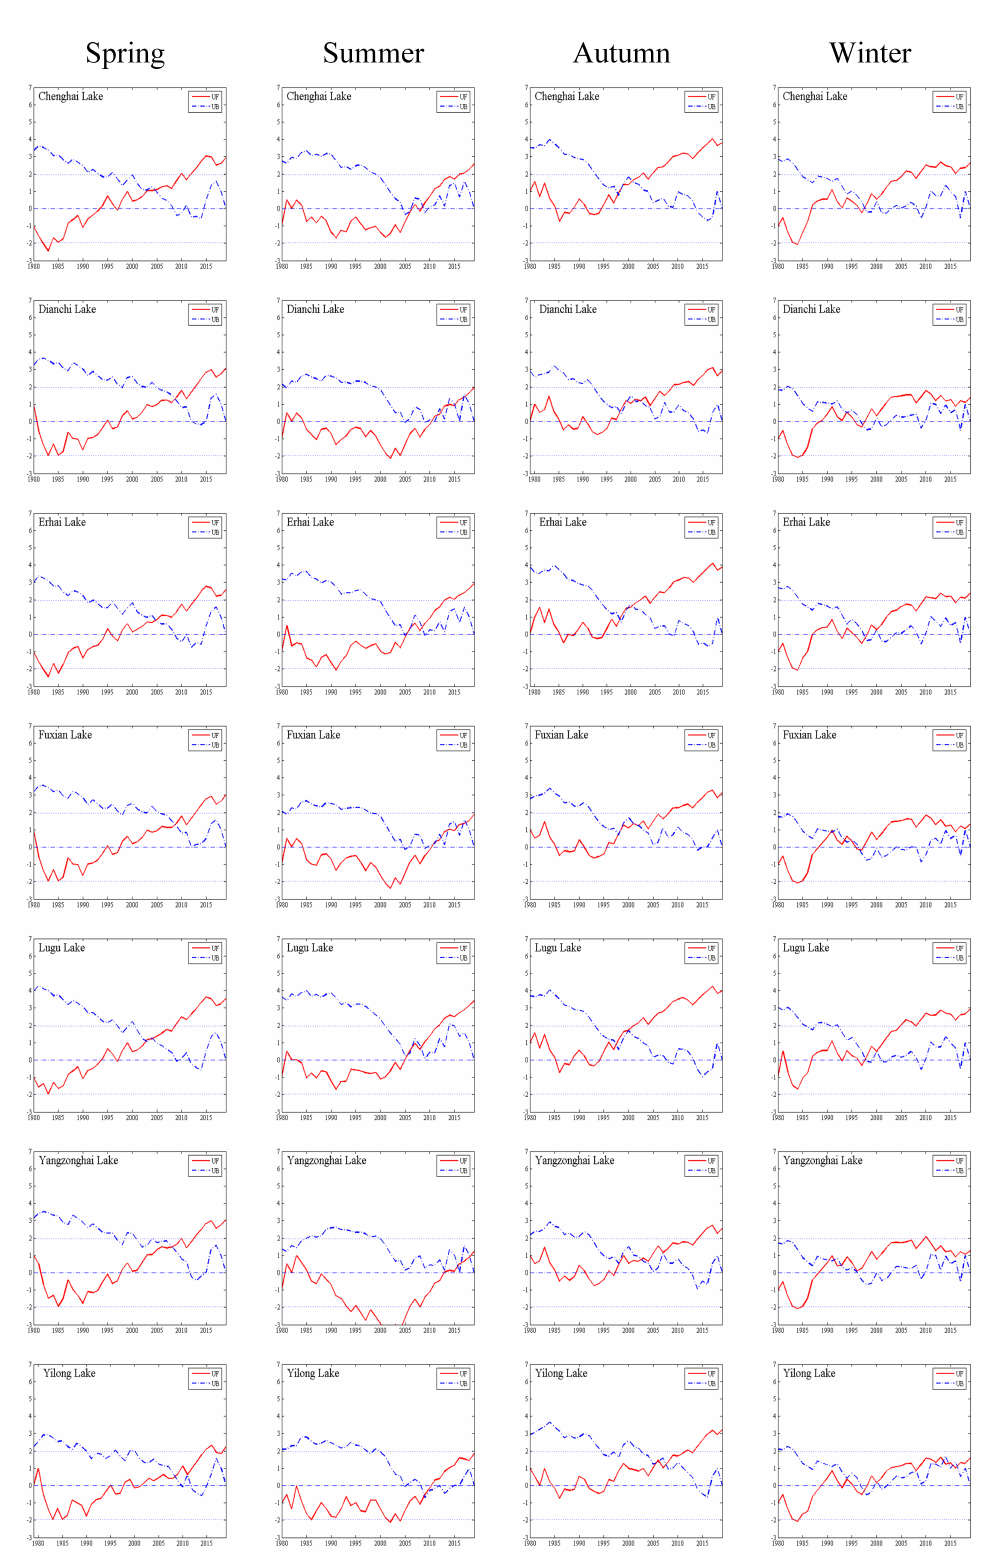
Figure 6. Sudden change point analysis of the seasonal mean temperature of lakes on the Yunnan Plateau from 1980 to